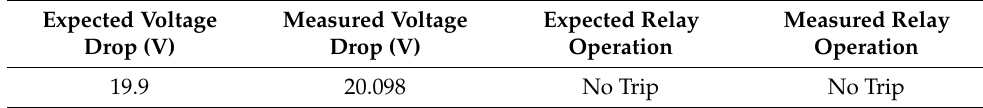
Table 6. Results comparison for the stable condition.